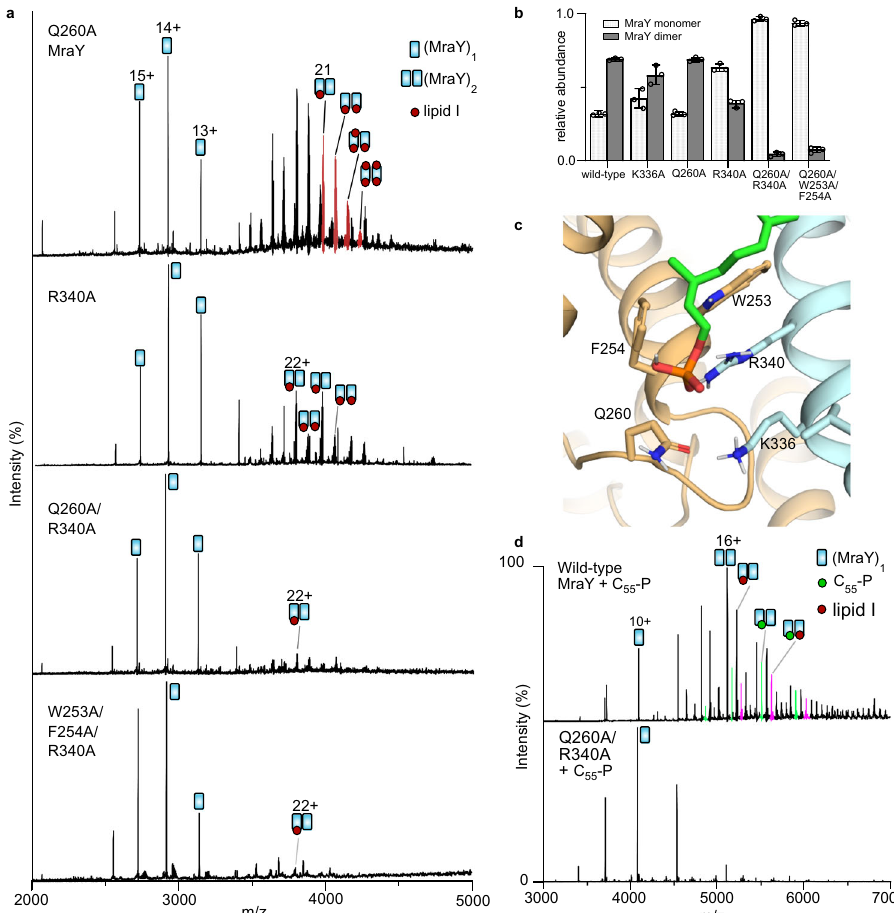
Fig. 2 MraY binding of carrier lipid is coupled to dimerisation. a Native mass spectra of MraY mutants. Shown are representative spectra of 5 µ M MraY protein variants: Q260A, R340A and Q260A/R340A and W253A/F254A/R340A all liberated from 1% OG micelles. Expression and puri fi cation conditions, as well as instrument settings, are identical to those of wild-type MraY (cf. Fig. 1a). Monomer-dimer proportions are consistent for replicate protein preparations. Masses are given in Supplementary Table 2. b Relative proportions of monomer and dimer species for the wild type and mutants of MraY. For Q260A, each MraY dimer was detected as a complex with 1 – 4 molecules of endogenous lipid I and little or no disruption of the dimer was observed relative to the wild type. For R340A, both ligand binding and dimerisation were impaired. For the hybrid mutants (Q260A or W253A/F254A with R340A on the other protomer), predominantly ligand-free monomers were observed in each case. Each protein was expressed and puri fi ed at least three times starting with a fresh transformation. The bar represents mean ± SD ( n = 3), each circle represents individual biological replicates. Source data are provided as a Source data fi le. c Zoom-in view of C 55 -P binding pose (from Fig. 1c) showing C 55 -P and the coordinating residues represented as sticks. d Spectra recorded for 5 µ M MraY (wild type and Q260A/R340A mutant) upon titration with 50 µ M C 55 -P. The C 55 -P molecules bind and increase the relative proportion of dimeric wild-type MraY but little or no binding and/or dimerisation occur in the case of the mutant under the same conditions. Buffer and instrument settings were the same as for the data shown in Fig. 1b. Peaks exclusive to (MraY) 2 (C 55 -P) and (MraY) 2 (lipid I)(C 55 -P) are highlighted, green and pink,